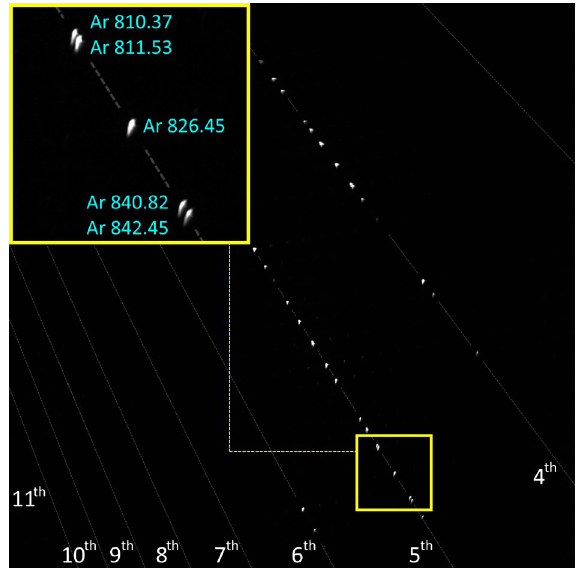
Fig. 2. Acquired line spectra of a HgAr-lamp. Spectral lines appear in the 4 th to the 6 th diffraction order. The image positions of all usable diffraction orders are marked by dashed lines. The inset shows a magnified view of specific spectral